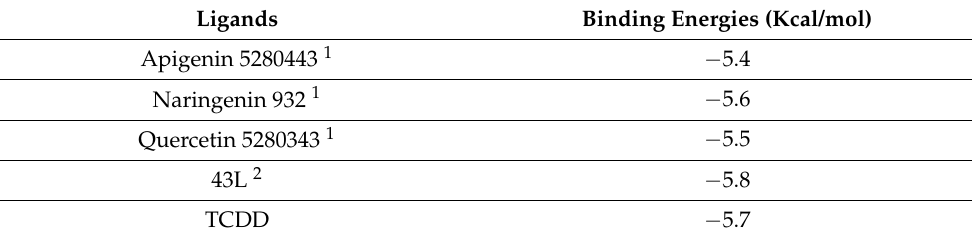
Figure 4. AHR bound with the flavonoids quercetin, naringenin, and apigenin ligands using autodock from mgltools. Table 2. AHR ligands and their docking energy with AHR. TCDD: